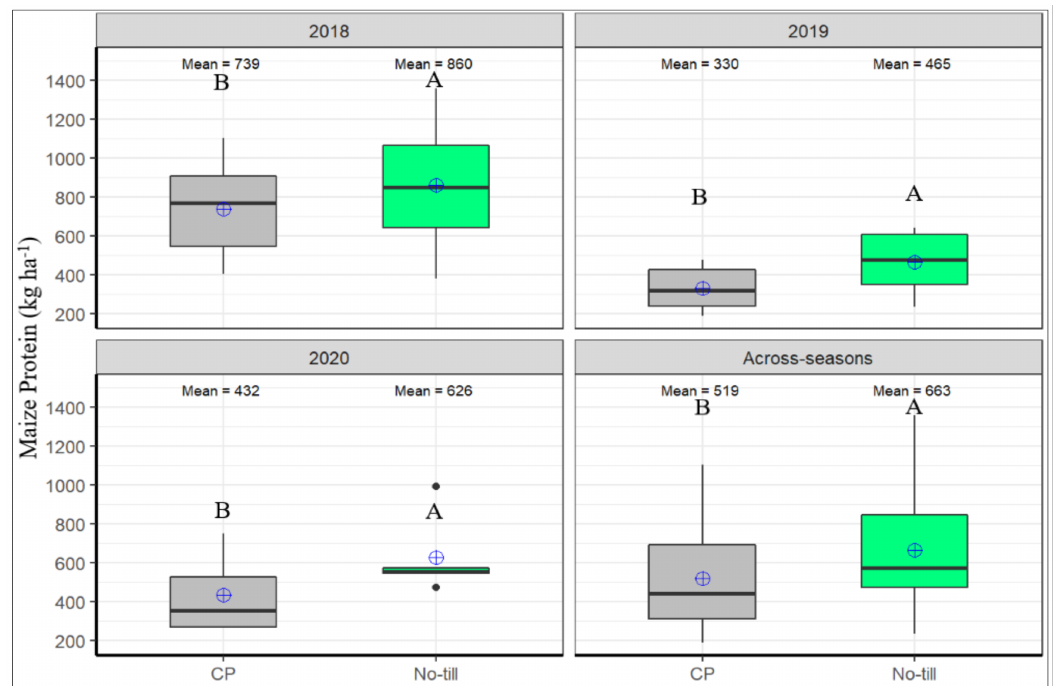
Figure 6. Protein contributions from conventional practice and NT treatments under maize cropping system in 2018, 2019, 2020 and across the growing seasons. Means with different letters (A, B) in the same season are significantly different at p < 0.05.